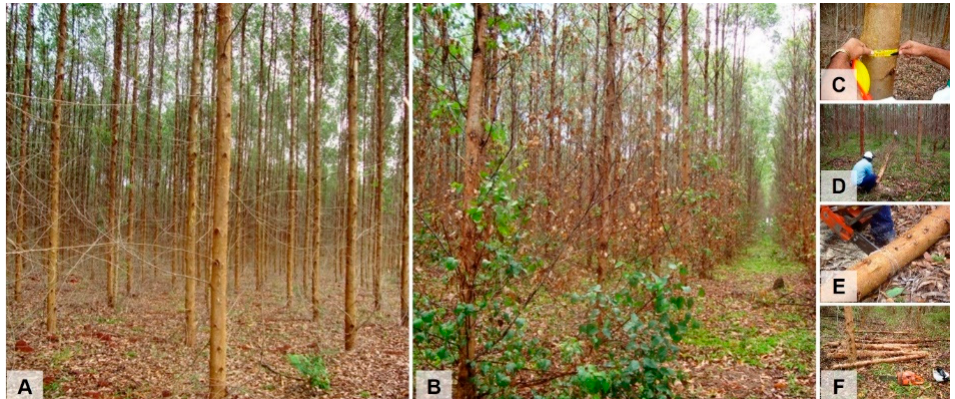
Figure 1. Visual effects of Eucalyptus grandis × Eucalyptus urophylla clone plantations under lower EPD symptoms ( A ) and higher EPD symptoms ( B ); field sampling ( C – F ).